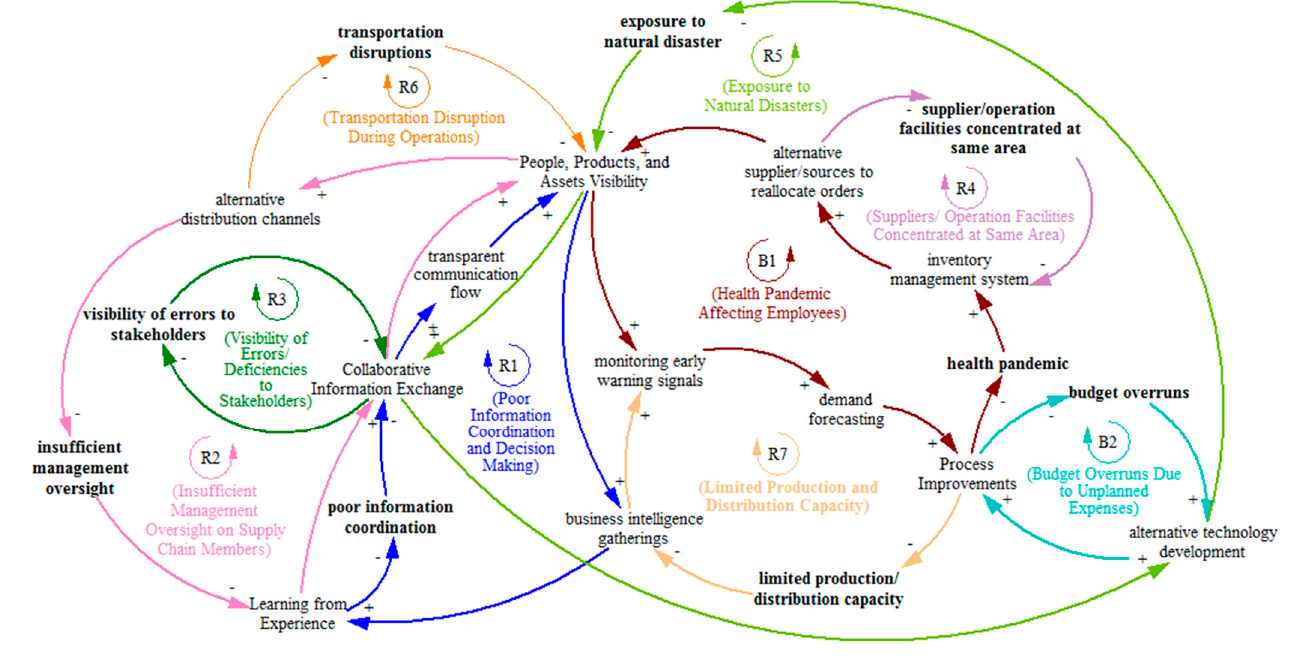
Figure 3. The causal loop diagram.